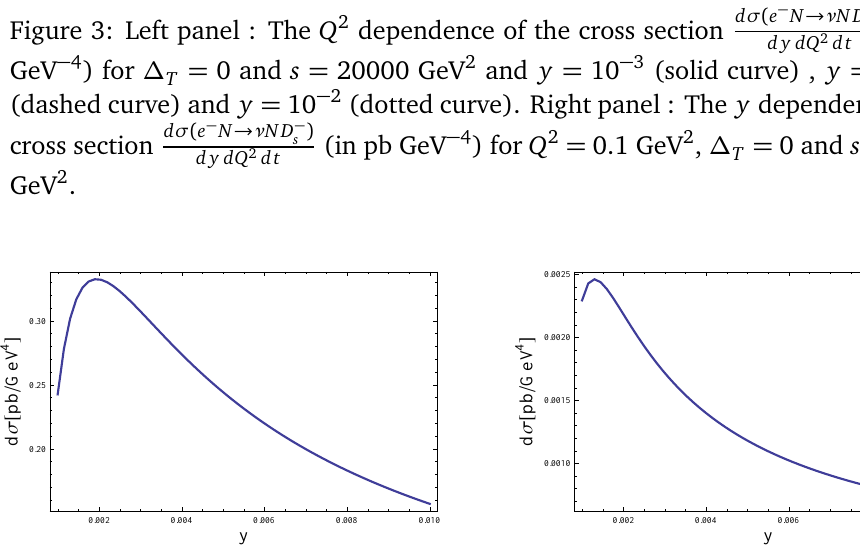
Figure 4: Left panel : The y dependence of the longitudinal cross section ) d σ ( e − N → ν ND −∗ = 0 and s = 20000 GeV 2 and Q 2 = .1 GeV 2 s (in pb GeV − 4 ) for ∆ T d y dQ 2 dt . Right panel : idem for the production cross-section of a transversely polarized D −∗